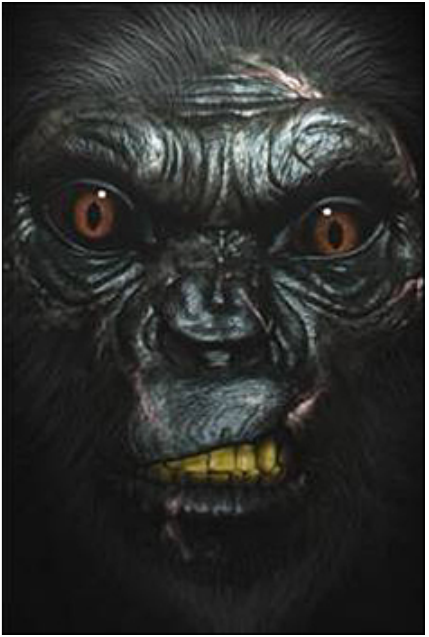
Figure 2. This very recent rendering of a “Neanderthal”, whose artist does not deserve to be named, reflects the views of many Pleistocene